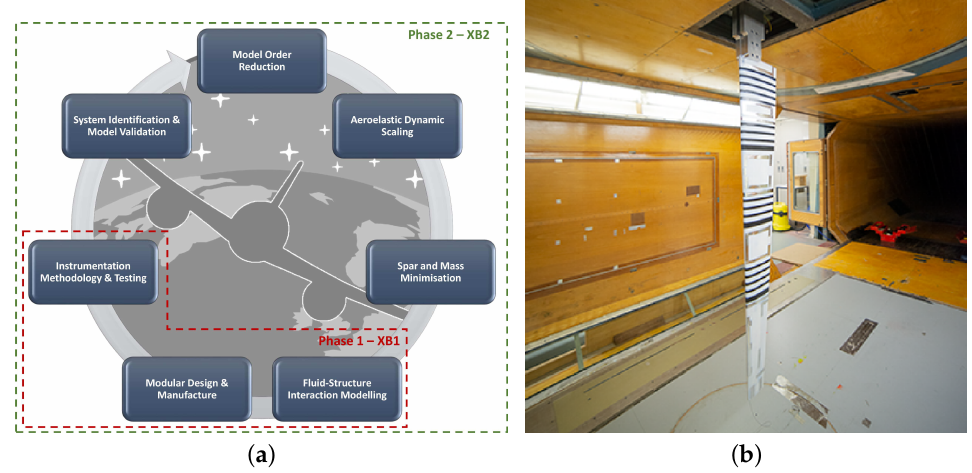
Figure 1. ( a ) BeaRDS work flow (Retrieved from [2]) and ( b ) XB-2 in the 8’ × 6’ Cranfield University’s wind tunnel (Retrieved from